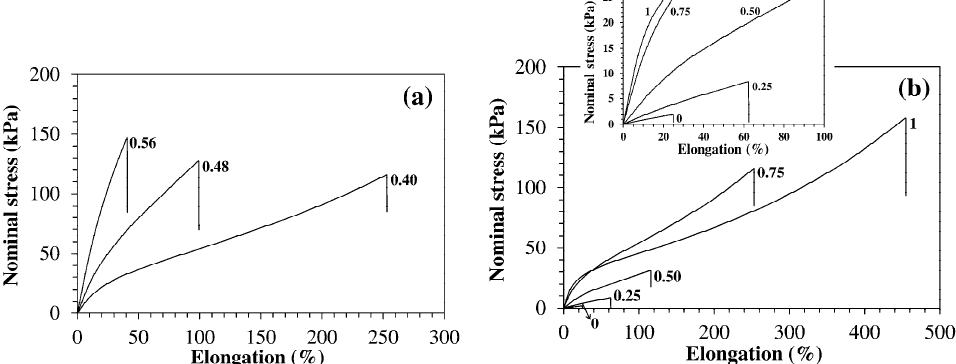
Figure 11. Stress vs. strain behavior of HM hydrogels (tests run in air on specimens equilibrated in NaCl 0.1 M, T = 23°C). ( a ) Hydrogels synthesized using f ODA = 0.75 and the indicated values of f JD400 . ( b ) Hydrogels synthesized using f JD400 = 0.40 and the indicated values of f ODA . Inset: Initial portion of the stress-strain curves.